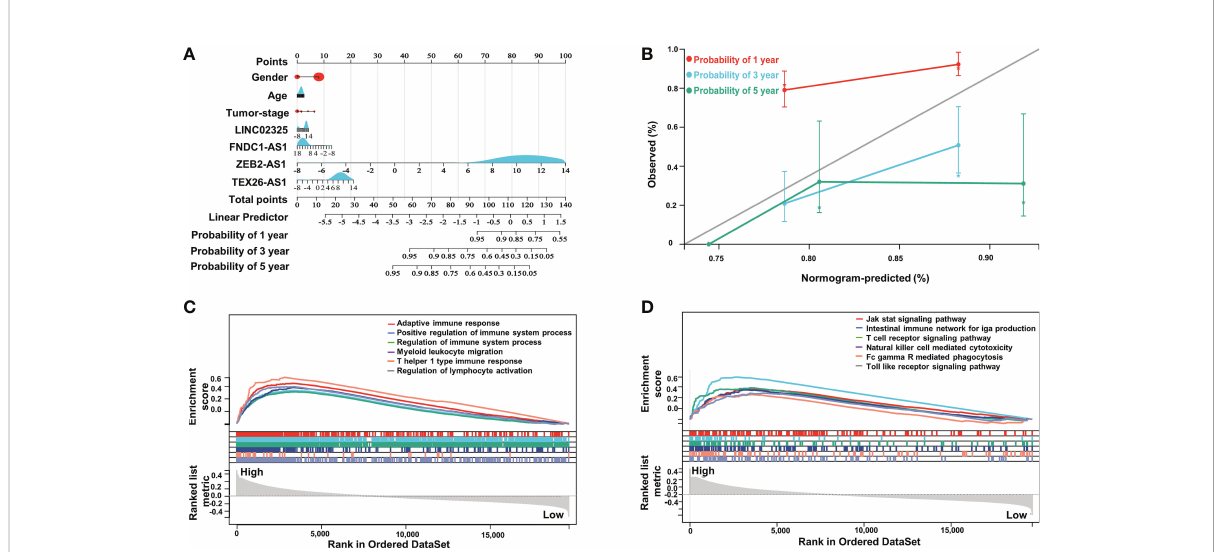
FIGURE 3 Nomogram analysis of four IRlncRNAs and GSEA between the two subgroups. (A) Nomogram of the clinical prognostic model based on sex, age, stage, and the expression of four IRlncRNAs. (B) Calibration curves for the 1-, 3- and 5-year survival plots comparing the actual and predicted values. (C) GSEA indicated signi fi cant enrichment of immune-related phenotypes in high-risk PaCa patients based on c5.go.bp.v7.4.symbols.gmt; (D) was based on